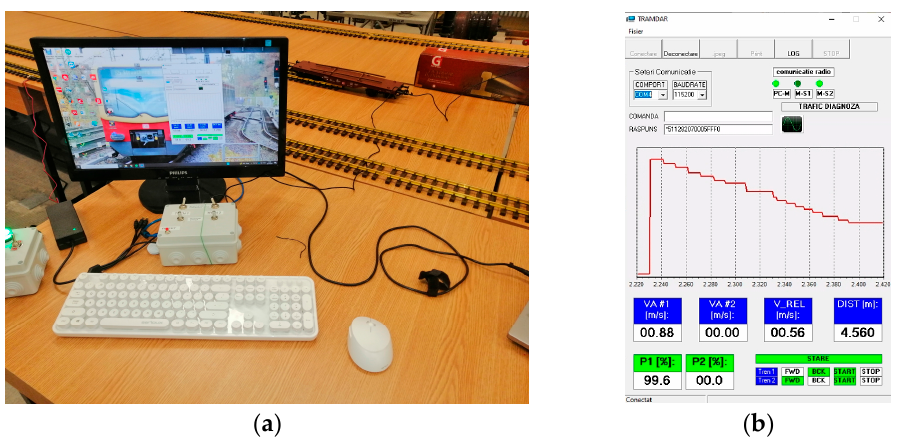
Figure 7. Master Control Unit setup: ( a ) data analyzed on the PC; ( b ) online data analyzed on the PC (screen